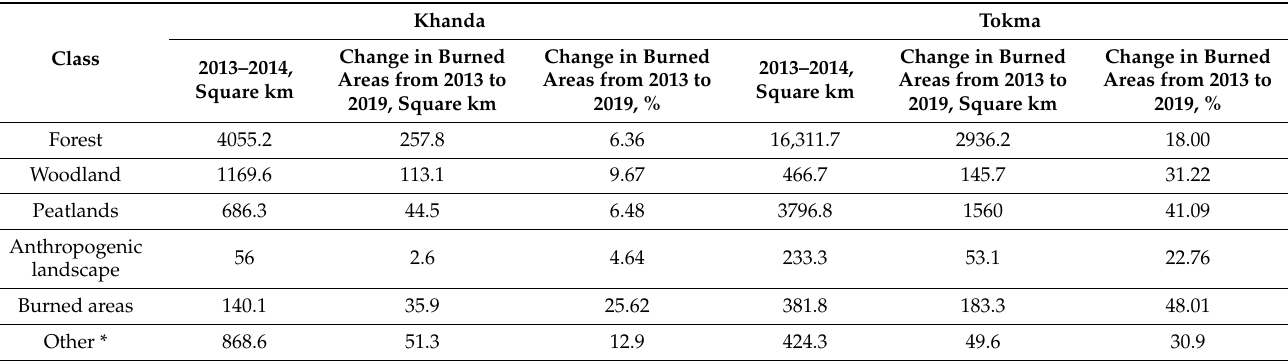
Table 1. Burned areas by types of land